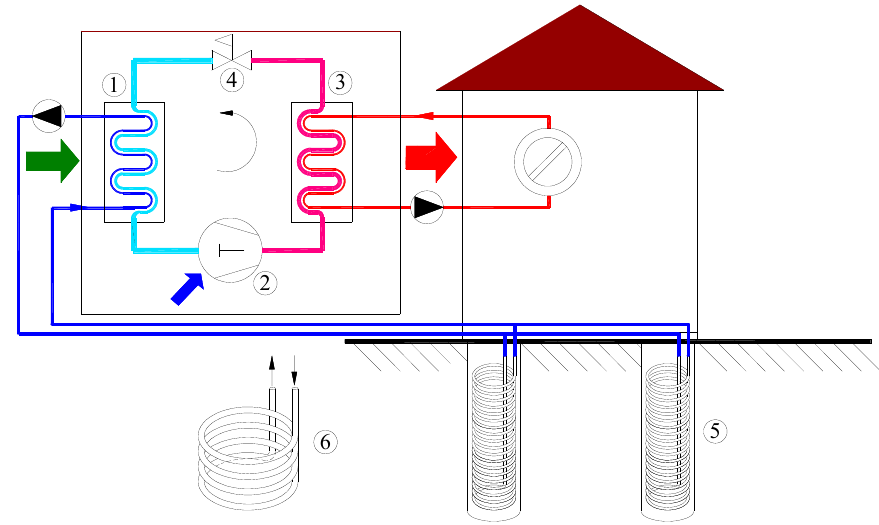
Figure 4. Shallow heat exchanger coupled to the heat pump (1—evaporator, 2—compressor, 3—condenser, 4—expansion valve, 5—energy piles, 6—large diameter coil GHE).